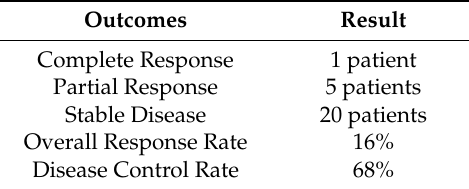
Results of a phase I clinical trial to investigate BLU-544 in pretreated advanced hepatocellular carcinoma. Outcomes Result Complete Response Partial Response